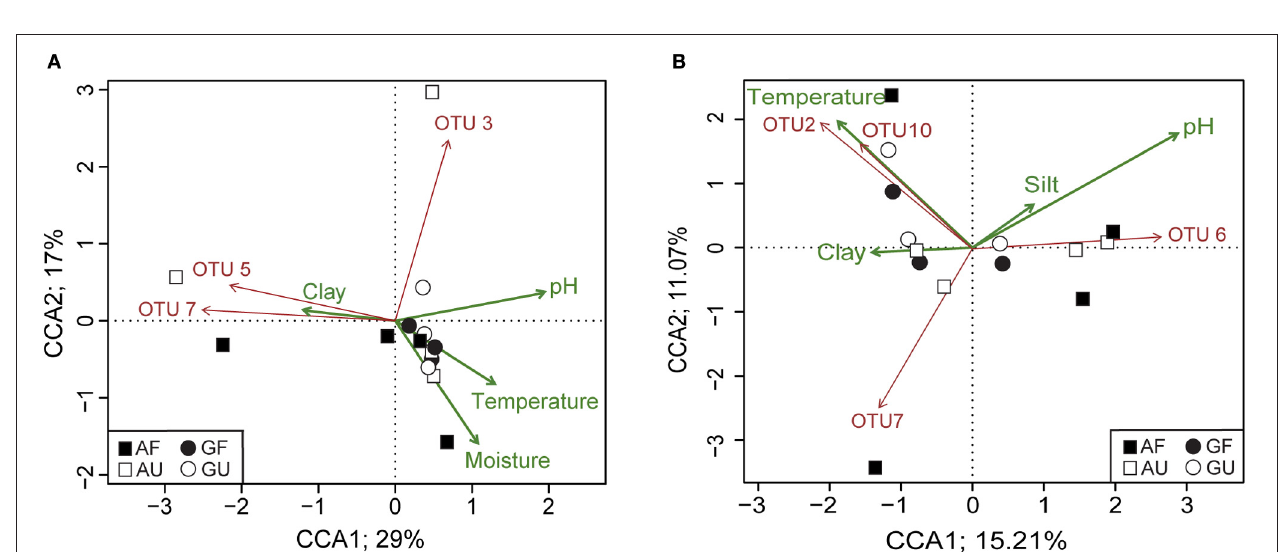
FIGURE 4 | Non-metric multidimensional scaling analysis of AOA communities as determined by clone library analysis (A) and microarrays (B) based on Bray-Curtis’ distances of relative abundances of OTUs defined at 15% nucleotide sequence dissimilarity. Confidence ellipses (95%) surround the centers of AOA communities derived from geothermally heated (solid red lines, GF and GU) and ambient temperature